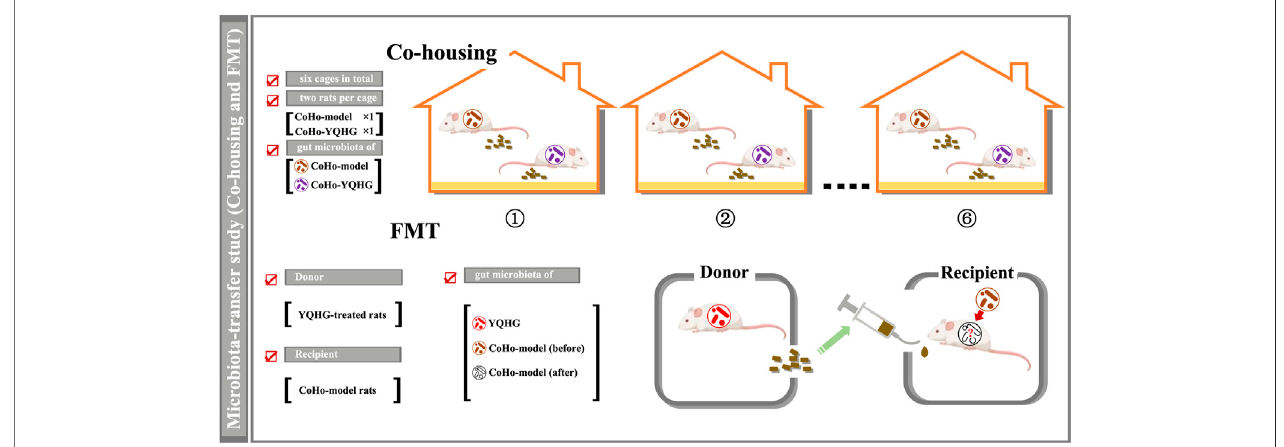
FIGURE 6 | Design of microbiota-transfer study (Co-housing and